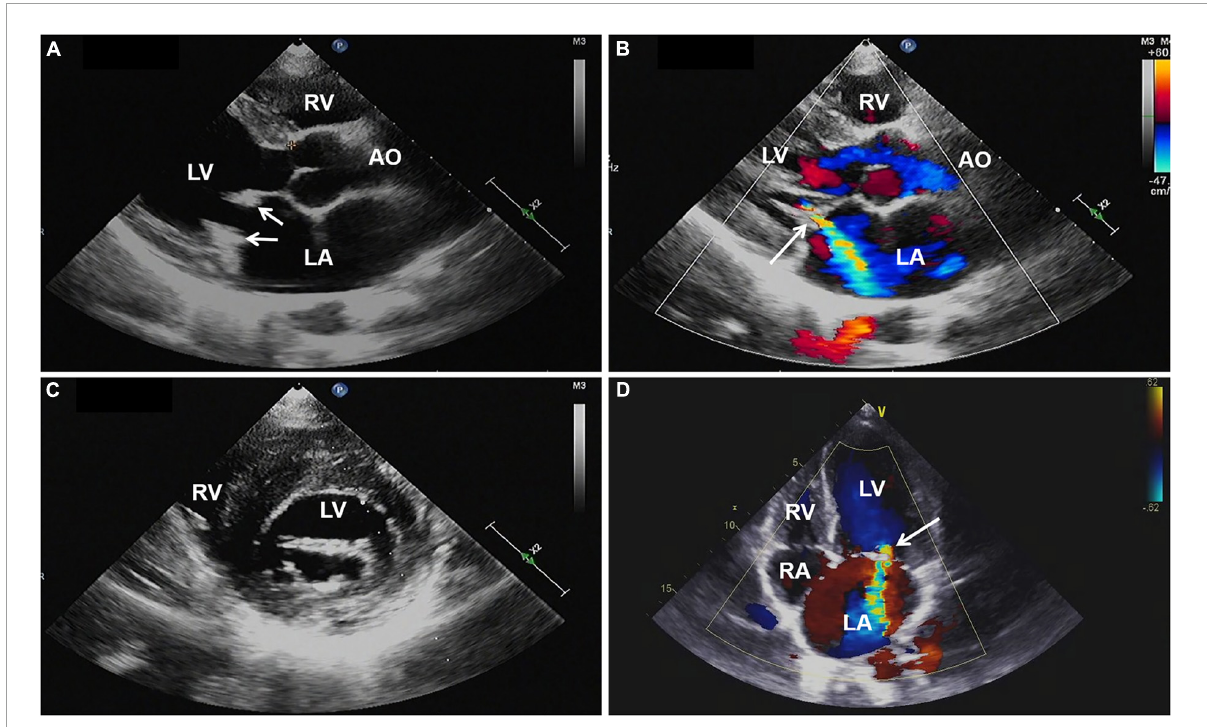
FIGURE2 (A,C) Transthoracic echocardiography showing thickened mitral valve leaflets with verrucous, nodular, heterogeneous echoic vegetations located on the commissural border of both leaflet tips (arrows). (B,D) Color Doppler imaging revealing mild to moderate mitral regurgitation (arrow). AO, aorta; LA, left atrium; LV, left ventricle; RA, right atrium; RV, right ventricle; TTE, transthoracic